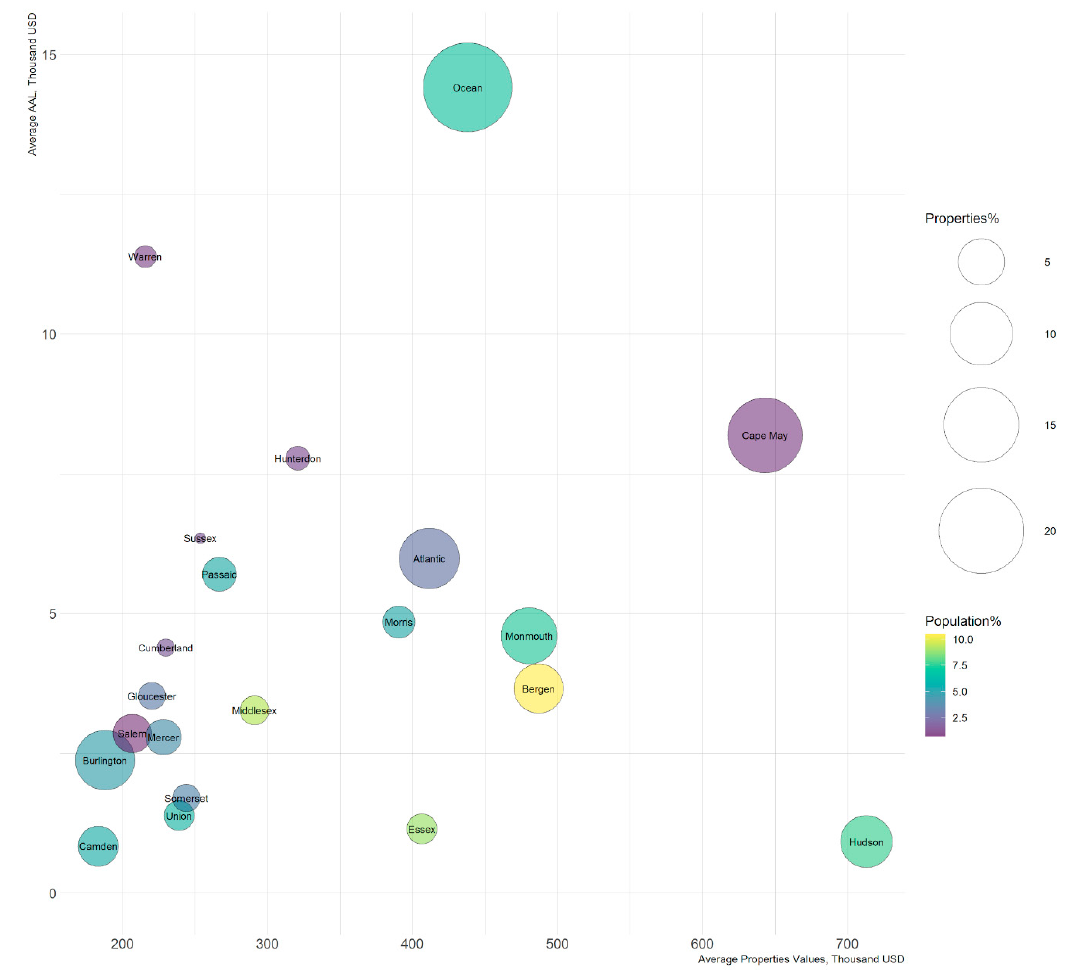
Figure 10. Average of expected AAL values and properties values for di ff erent counties in New Jersey; The color and size represent the percentage of total population and total number of properties, respectively.